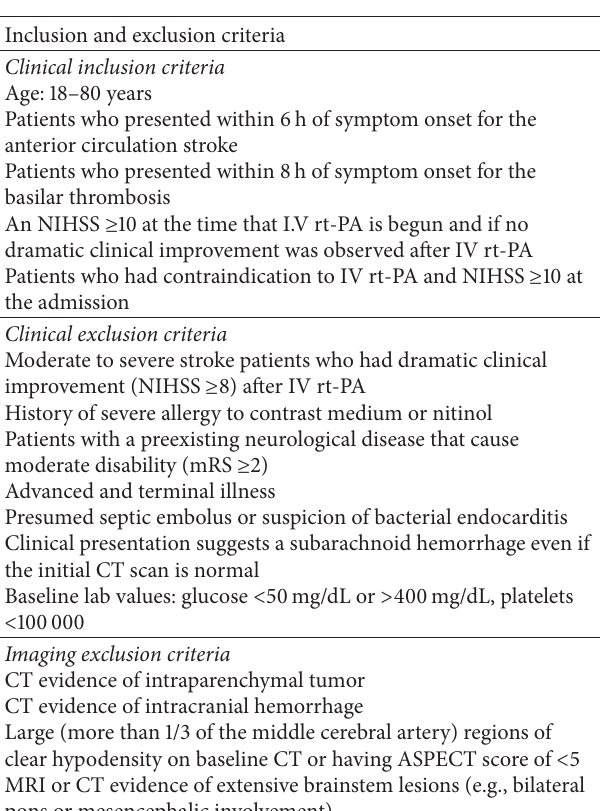
Table 1: Patient selection criteria for endovascular stroke treatment with stent